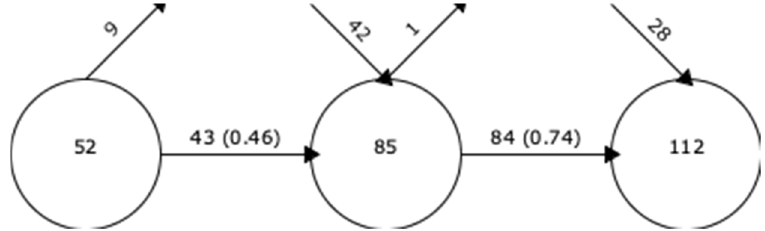
Figure 7. Stability between periods. Overlapping graph of keywords from 1987 to 2021.